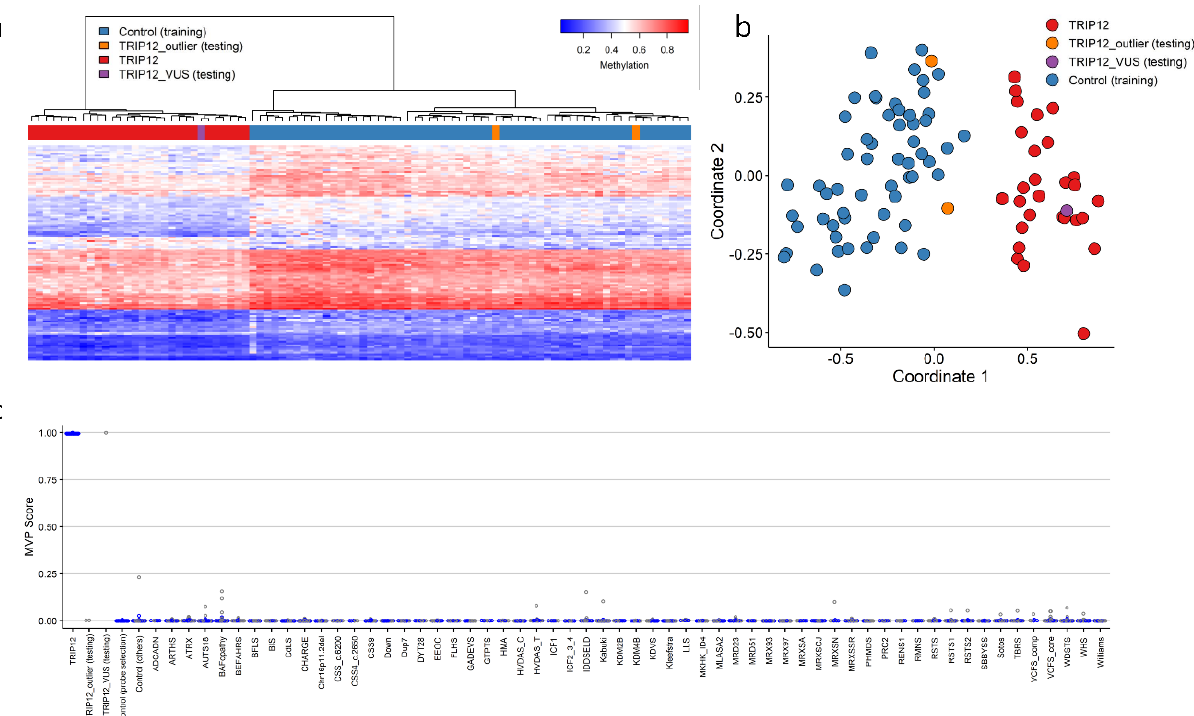
Figure 5. Assessment of TRIP12 variant of uncertain significance (VUS) using the Clark–Baraitser syndrome ( TRIP12 ) episignature: ( a ) Euclidean hierarchical clustering (heatmap): each column represents a TRIP12 case or control; each row represents 1 of the 118 CpG probes selected for the episignature. This heatmap shows clear separation between 29 TRIP12 cases (red) used for training from controls (blue). The VUS case (purple) is shown to segregate with training cases. Two outlier cases (orange) are shown to segregate with controls; ( b ) Multidimensional scaling (MDS) plot shows the segregation of the TRIP12 VUS case with training and away from both controls and outlier cases; ( c ) Support Vector Machine (SVM) classifier model. Model was trained using the 118 selected TRIP12 episignature probes, 75% of controls and 75% of other neurodevelopmental disorder samples (blue). The remaining 25% controls and 25% of other disorder samples were used for testing (grey). Plot shows the TRIP12 VUS case with a methylation variant pathogenicity (MVP) score close to 1, similar to the TRIP12 training cases, showing the specificity of the classifier and